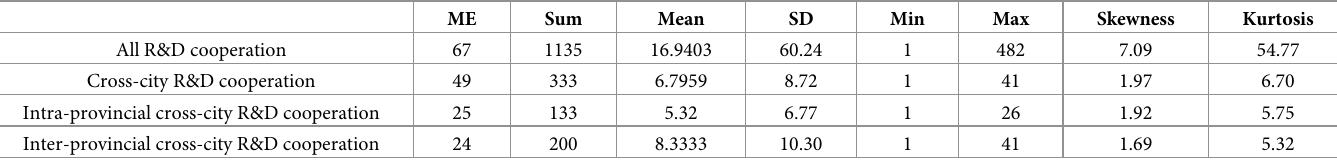
Table 3. Descriptive statistics of the Yangtze River Delta 2011–2013.